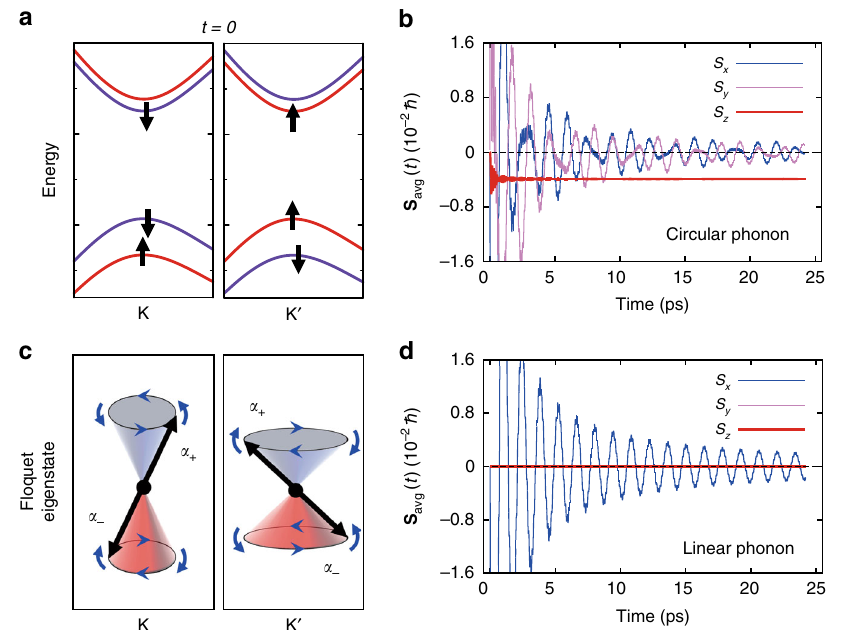
Fig. 4 Phonon induced spin-Floquet magnetism. a Schematic for the electronic con fi guration with one spin-down and spin-up electron being added onto the K and K ′ valley, respectively. b Cumulative time average of the total spin of MoS 2 being driven by the circularly polarized E ″ phonon. c Schematics for the two spin-Floquet eigenstates at K and K ′ de fi ned by the right-circularly polarized phonon. d The same time-averaged total spin with the linearly polarized phonon. Details of each component on each valley are given in Supplementary Fig.